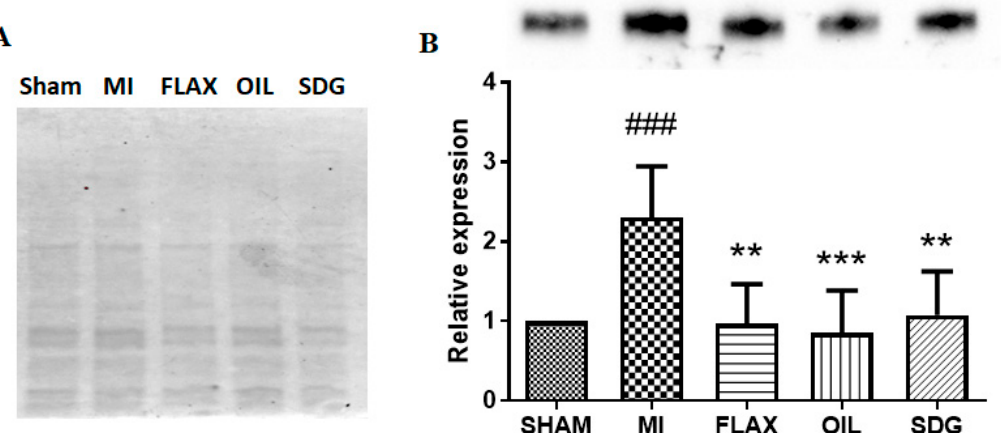
Figure 2. E ff ect of the dietary interventions on collagen I levels. ( A ), TGX gel visualization by Bio-Rad Figure 2. Effect of the dietary interventions on collagen I levels. A , TGX gel visualization by Bio-Rad Gel Doc TM XR + imager to confirm equal protein loading. ( B ), Densitometric quantification of the Gel Doc TM XR+ imager to confirm equal protein loading. B , Densitometric quantification of the immunoblots, data are presented as mean ± SD, n = 5–6. ### Significantly di ff erent from sham, p immunoblots, data are presented as mean ± SD, n = 5–6. ### Significantly different from sham, p < 0.001; < 0.001; ** significantly di ff erent from MI, p < 0.05; *** significantly di ff erent from MI, p < 0.001. ** significantly different from MI, p < 0.05; *** significantly different from MI, p < 0.001; **** ALA, alpha-linolenic acid; FLAX, chow diet supplemented with 10% ground flaxseed; MI, myocardial Significantly different from MI, p < 0.0001. ALA, alpha-linolenic acid; FLAX, chow diet supplemented infarction; OIL, chow diet supplemented with 4.4% ALA enriched flax oil; SDG, chow diet supplemented with 10% ground flaxseed; MI, myocardial infarction; OIL, chow diet supplemented with 4.4% ALA with 0.44% secoisolariciresinol enriched flax oil; SDG, chow diet supplemented with 0.44% secoisolariciresinol diglucoside.